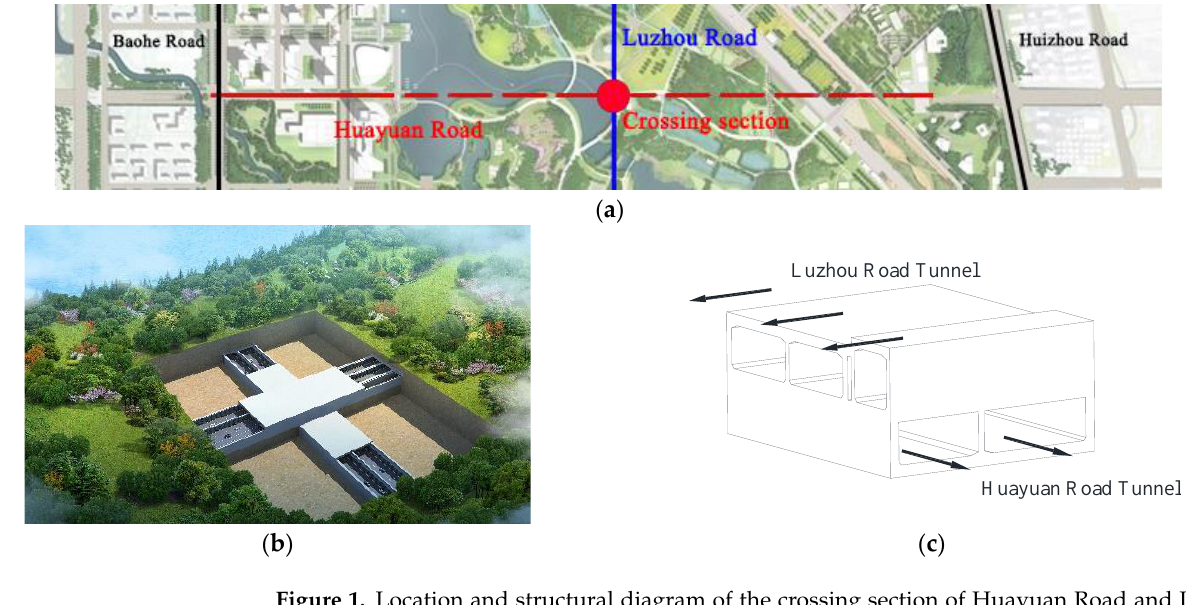
Figure 1. Location and structural diagram of the crossing section of Huayuan Road and Luzhou Road: ( a ) plane layout, ( b ) three-dimensional location diagram of crossing section and ( c ) structural frame diagram of crossing section.